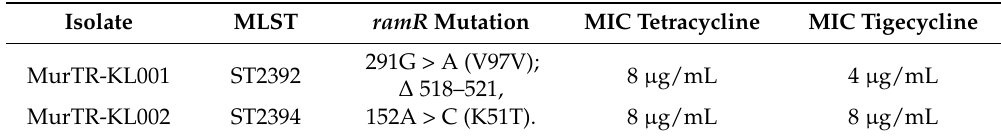
Table 1. Characterization of tigecycline-resistant Klebsiella pneumoniae